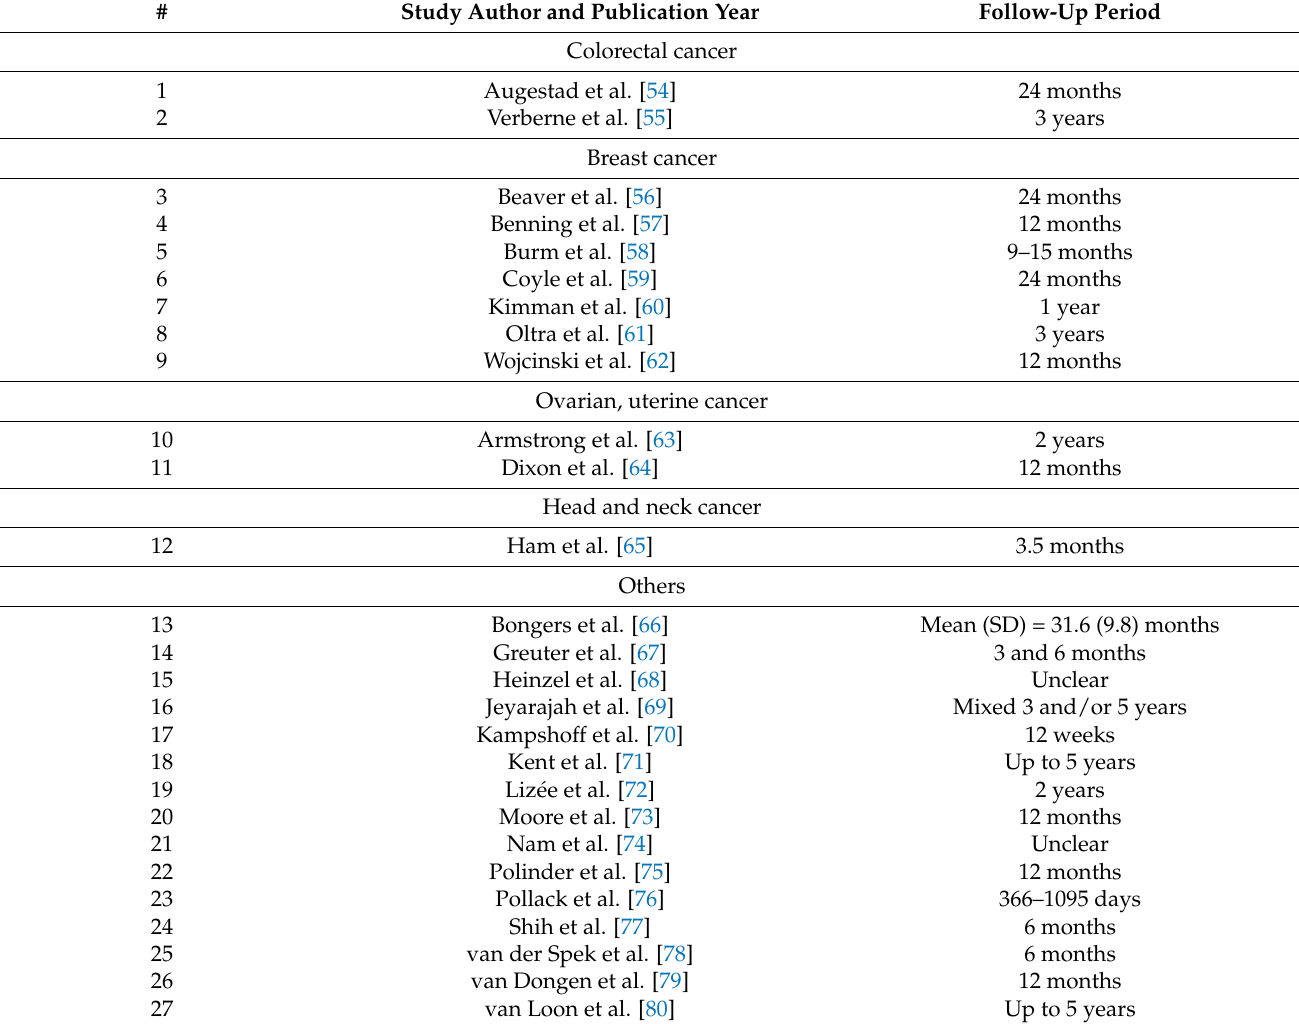
Table A4. A list of studies that met many inclusion criteria (“near-misses”) but were excluded due to a short follow-up period (less than 5